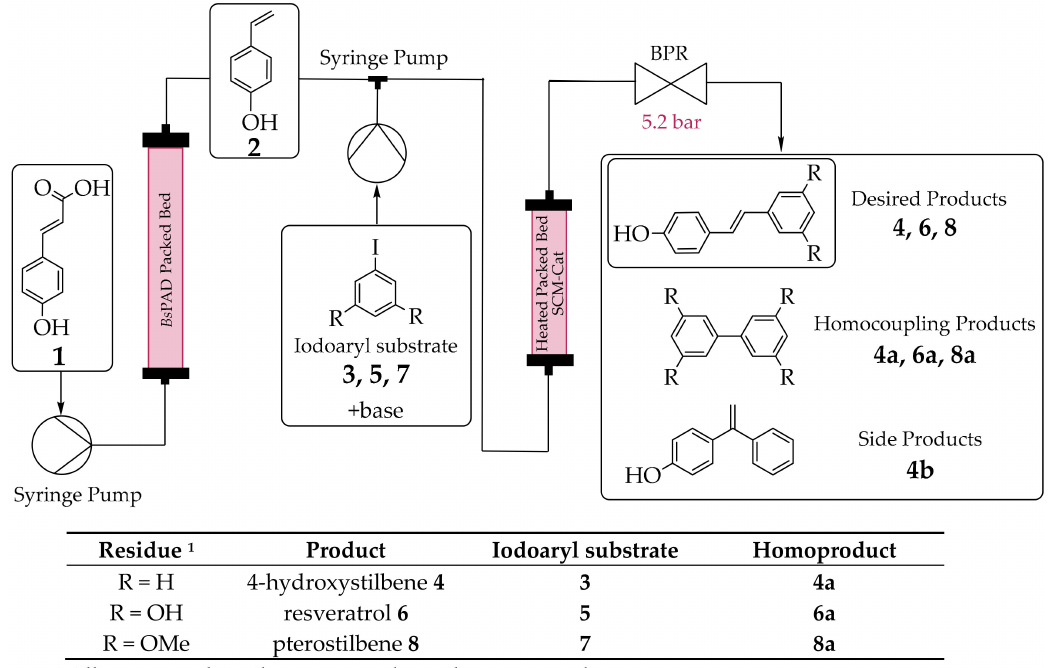
Figure 2. Scheme of the chemoenzymatic cascade for the synthesis of stilbenes in continuous flow; enzymatic decarboxylation is achieved by pumping a coumaric acid 1 solution (20 mM, in DES:KPi